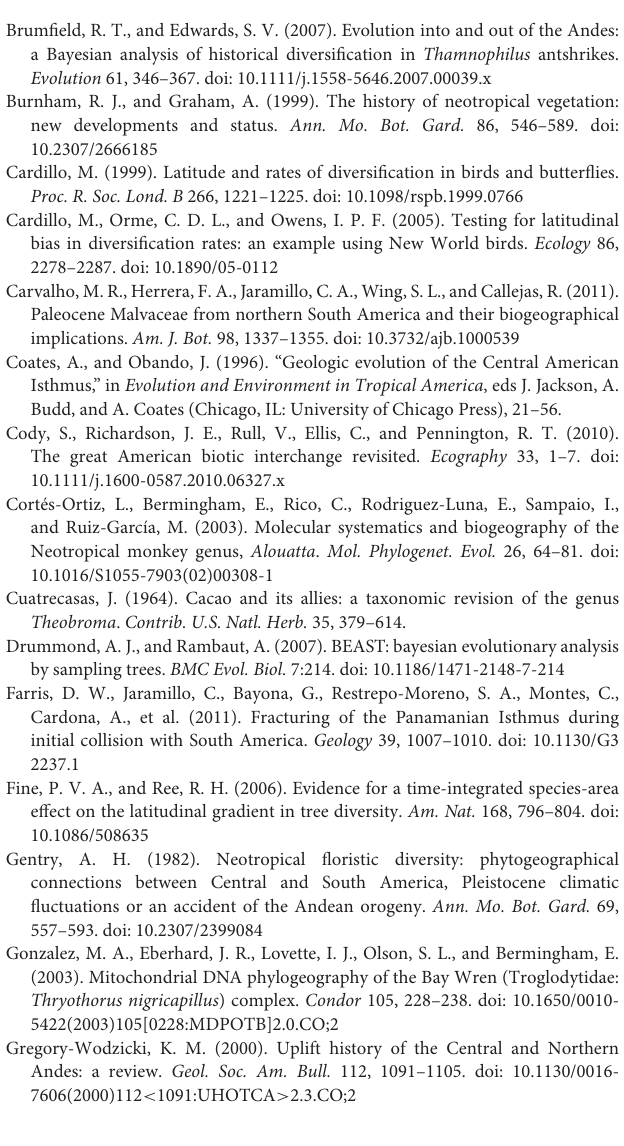
Supplementary Figure 3 | MCC tree from the BEAST analysis of the WRKY data that includes error bars on node age estimates and posterior probabilities of